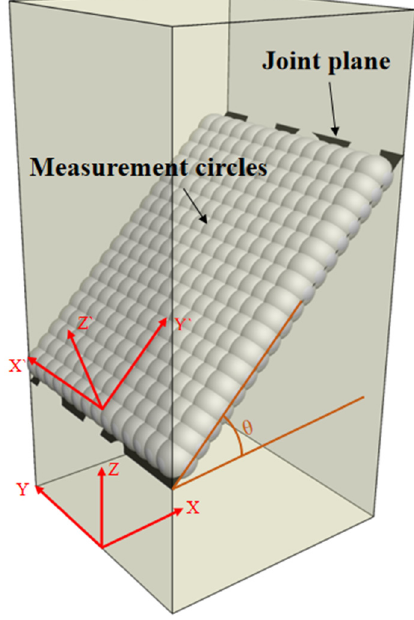
Figure 15. Measurement circle distribution around the joint plane. During loading, the normal stress distribution in the 3D nonpersistent joint plane is characterized as shown in Figure 16. For the specimen with different inclinations, at the initial stage of loading (for the stress state in point a), stress concentration occurs in the rock bridge. However, it is worth noting that the stress concentration on the joint surface is relatively weak for specimens with inclinations of 75° and 90°. For the specimen with inclination θ = 0°, before failure, the stress concentration area on the joint plane has little change (Figure 16a). The main reason is that the specimen experiences splitting failure, and all rock bridges play a supporting role under axial loading. For the specimen with θ = 75°, as the failure belongs to the shear mode, friction slip occurs along the joint plane during the postpeak stage. Then, a significant distinction in stress appears between rock bridges (Figure 16c). The normal stress of the rock bridge at θ = 90° is virtually unchanged, and some rock bridges deform and rupture at the last load failure stage, resulting in lo ‐ calized stress concentration. The stress concentration mainly occurs at the upper and lower ends (Figure 16d).